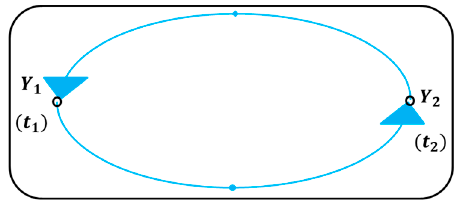
7 of 38 Figure 8. Vertex set V = { b, d, e } covers all nodes in graph G. In addition, we can use graphs to perform real-time threat analysis. This can enable security analysts to deploy defense mechanism accordingly [66]. We can also present the failure attempts on a particular system via graphs. An example of this is shown in Figure 9. Figure 9. Login failures attempt analysis on a specific system using graphs. The comprehensive details given in Figure 9 enable the security analyst to ensure best protection for the victim machine. Accordingly, the classification of the insider and outsider threats can be performed by informative analysis offered by interactive graphs. 2.4. Services Connectivity Analysis Using Graphs An algorithm can be presented with the help of graph where different services are presented as nodes of the graph and edges are used to link these services with each other. These services are used to execute the algorithm. If there is a computer system S which is used to execute any specific algorithm A. If A is an isomorphic algorithm/service to a sub graph of computer system S . There is